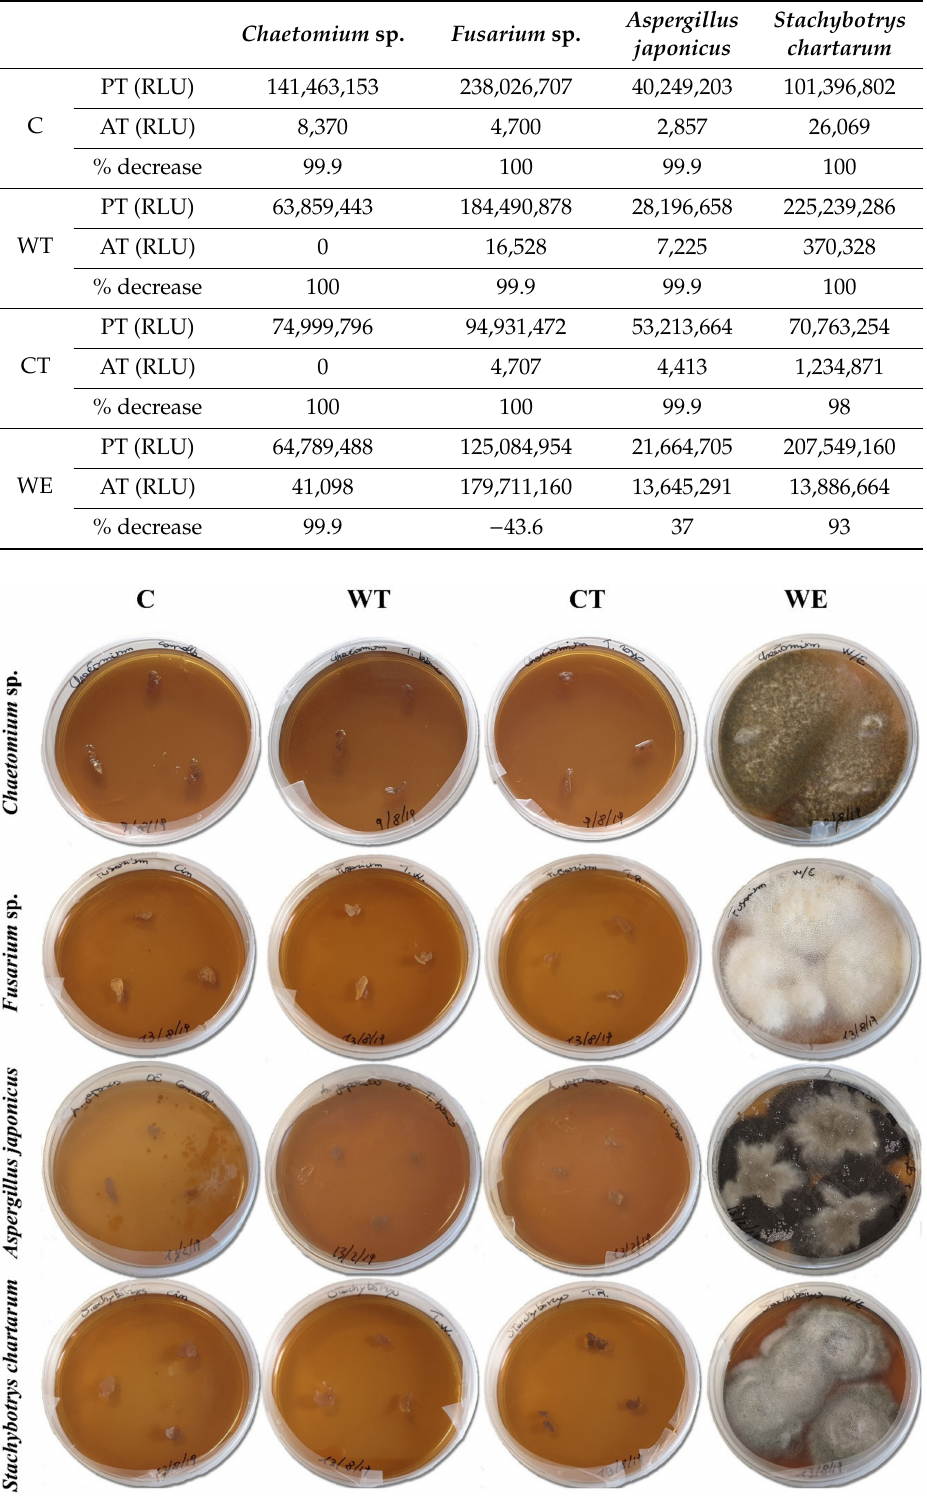
Table 4. Evaluation of the biocidal activity of the EOs MIC on fungal mycelia through ATP bioluminescence assay. (C: cinnamon; WT: wild thyme; CT: common thyme; WE: water-ethanol; PT: pretreatment, AT: after treatment).